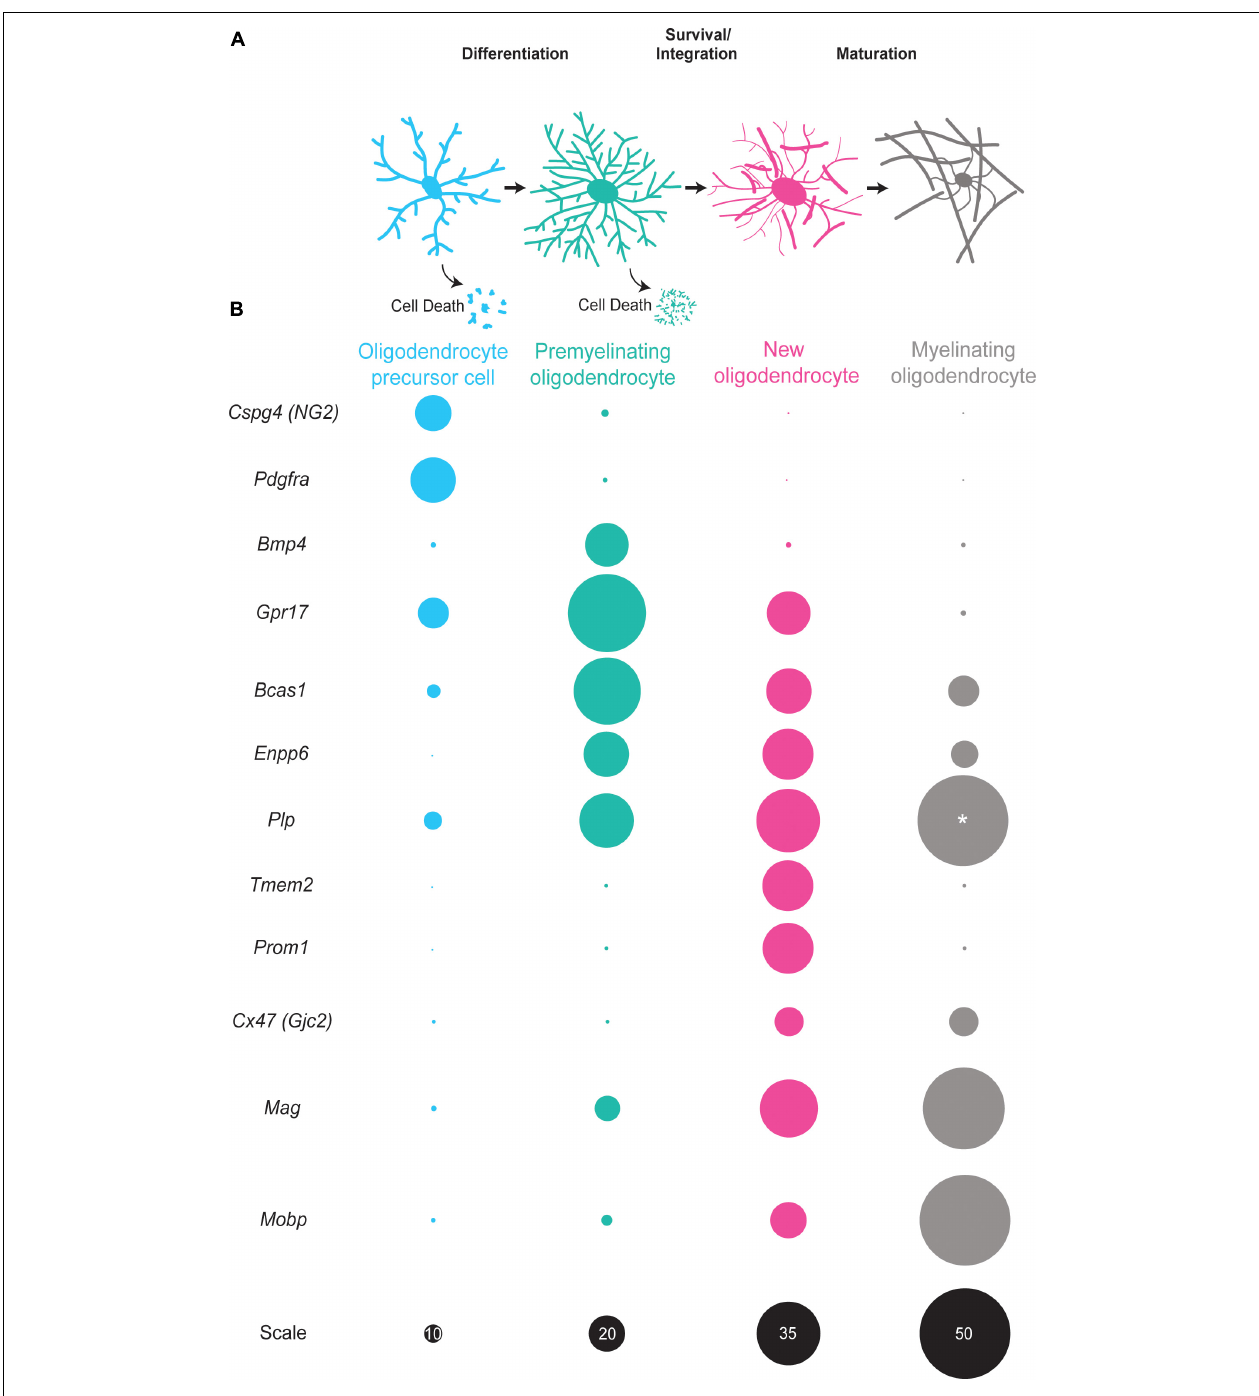
FIGURE 1 | The oligodendrocyte lineage progression and expression of stage-specific markers. (A) Oligodendrocyte precursor cells (blue) differentiate into premyelinating oligodendrocytes (teal). A large majority of premyelinating oligodendrocytes are lost but some survive and integrate into neuronal circuits as new oligodendrocytes (pink). New oligodendrocytes then have the capacity to form myelin sheaths and slowly mature into myelinating oligodendrocytes (gray). (B) Oligodendrocyte precursor cells (blue) express Cspg4 and Pdgfra mRNA in high levels. Premyelinating oligodendrocytes (teal) have increased expression of Bmp4 , Gpr17, Bcas1, and Enpp6 . New oligodendrocytes (pink) express some of the same mRNAs as premyelinating oligodendrocytes, yet are distinct as they express Tmem2 , Prom2, and Cx47 and have increased expression of myelin genes, such as Plp , Mobp , and Mag . Myelinating oligodendrocytes (gray) have high expression of myelin genes, such as Plp , Mobp , and Mag with little to no expression of Cspg4 , Gpr17 , and Enpp6 among others. Size of circles are relative to one another except for those labeled with “*” scale is given in black on the bottom row. The sizes of circles correlate with single cell RNA -sequencing data (Marques et al.,